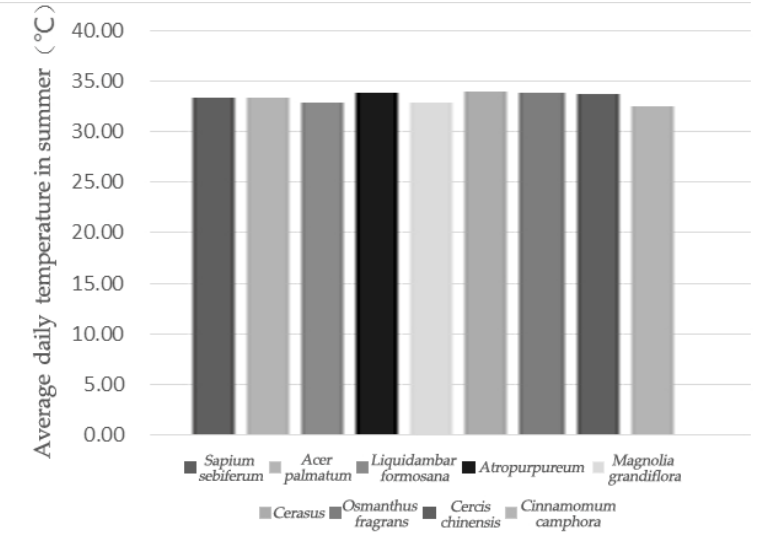
Figure 6. Average daily temperature per unit green area of different pure forests in summer.